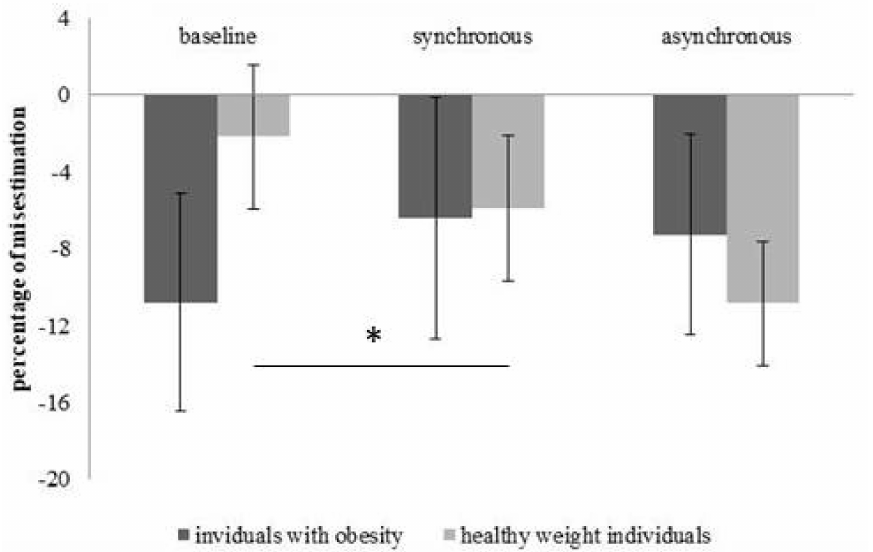
Figure 3. About the horizontal estimation of the shoulders, means of the percentage of misestimation and standard error (bars) were showed for participants a ff ected by obesity (dark grey bars) and healthy-weight participants (light grey) for the three experimental conditions. * indicates a significant di ff erence according to the Bonferroni-corrected p value of